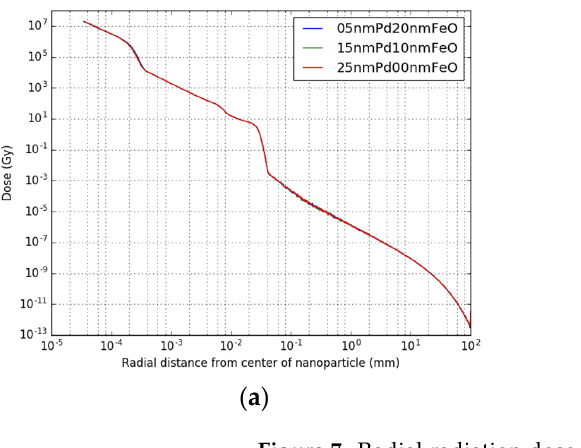
Figure 7. Radial radiation dose profile after 100,000 decays of: ( a ) the combined radiation of one nanoparticle with three core-shell topologies of 20, 10 and 0 iron oxide shell; and ( b ) a zoom-in of the dose profile around 1 × 10 − 4 mm distance.